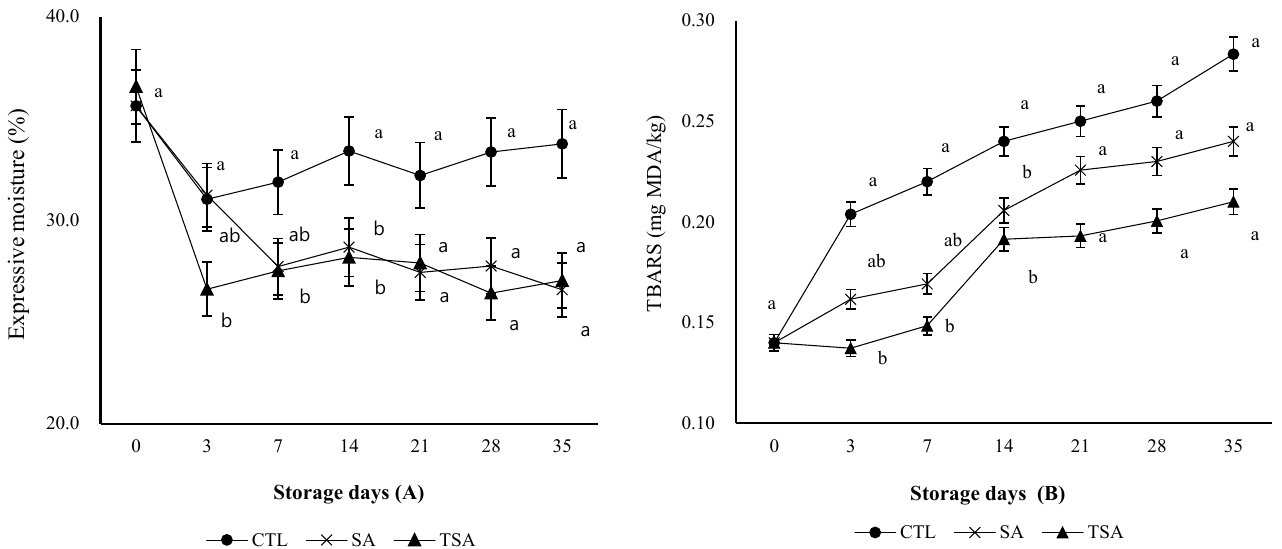
Figure 1. Expressive moisture (A) and thiobarbituric acid reactive substances (B) of low-fat pork saussages and those wrapped with SA and TSA films. EM, expressive moisture; TBARS, thiobarbituric acid reactive substances; CTL, low fat sausages without film; SA, low fat sausages wrapped with 2% sodium alginate film; TSA, low fat sausages wrapped with 2% sodium alginate and 1% cherry tomato powder film. a,b Mean with different superscript on the same day indicate significant differences at p<0.05.